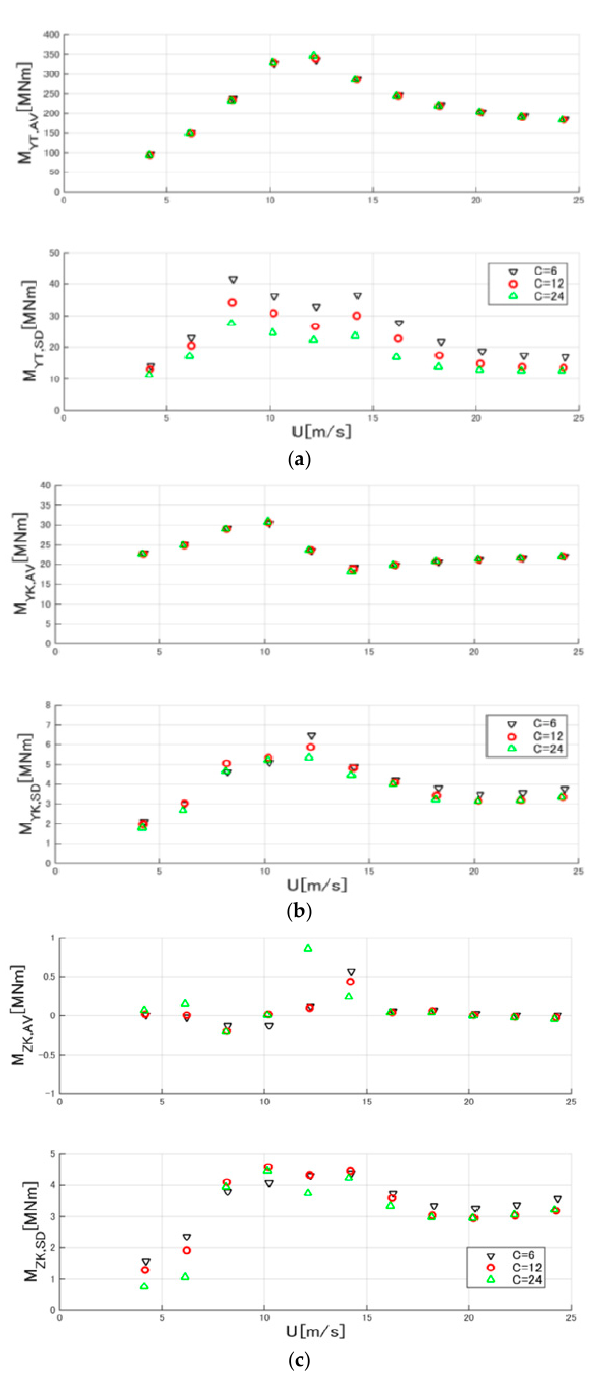
Figure 13. Mean and standard deviation of the tower loads to the average wind speed at the centre hub: ( a ) tower base fore ‐ aft bending moment; ( b ) tower top nodding moment; and ( c ) tower top yawing moment.